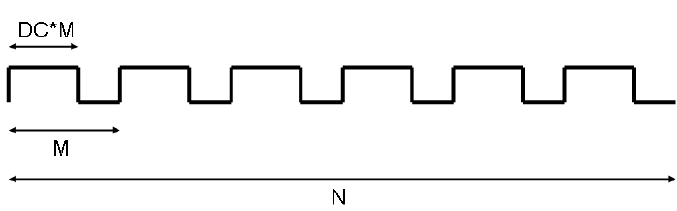
Figure 4. Representation of H [ i ] function, where N is the total sample size, N / M is the total number of pulses and DC * M is the pulse length (in samples).